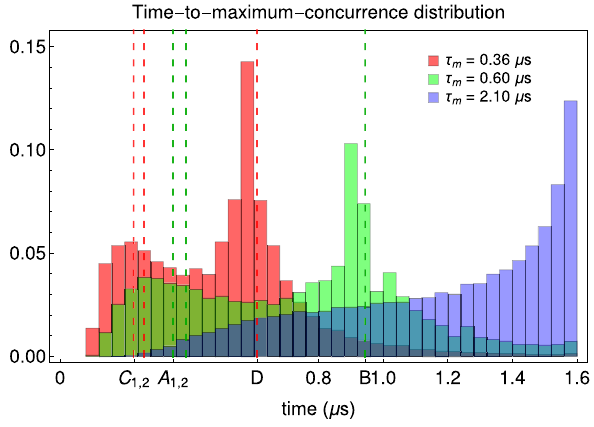
FIG. 4. Histograms of the time to maximum concurrence for individual trajectories for three measurement strengths indicated by the values of τ . For the two cases with strong readout powers m (shown in red and green histograms), there exists two peaks corresponding to two most-likely times to reach their most entangled states. The theoretical predictions of these times are shown as vertical dashed lines labeled as A 1 , B , C 1 , D [same as ; 2 ; 2 in Figs. 3(a) –